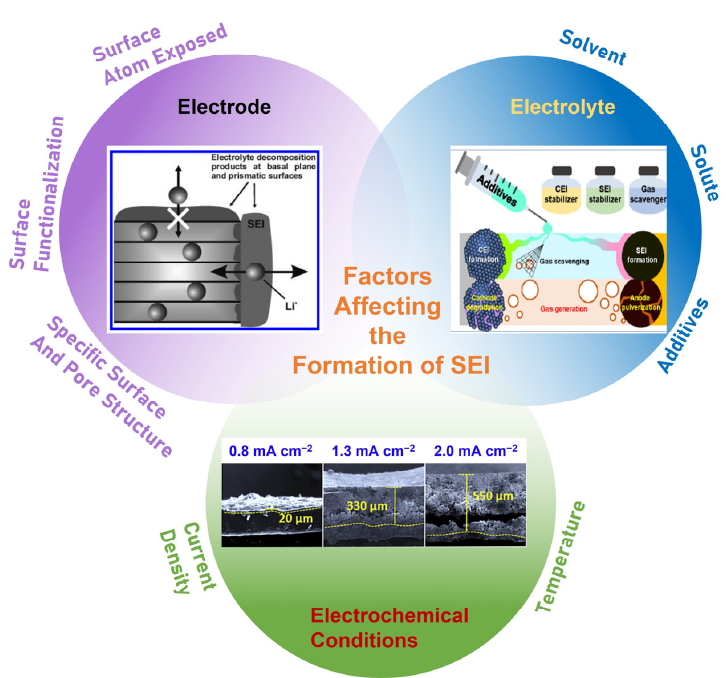
Figure 1. Schematic diagram of the factors (electrodes, electrolyte and electrochemical conditions) a ff ecting the formation of SEI.